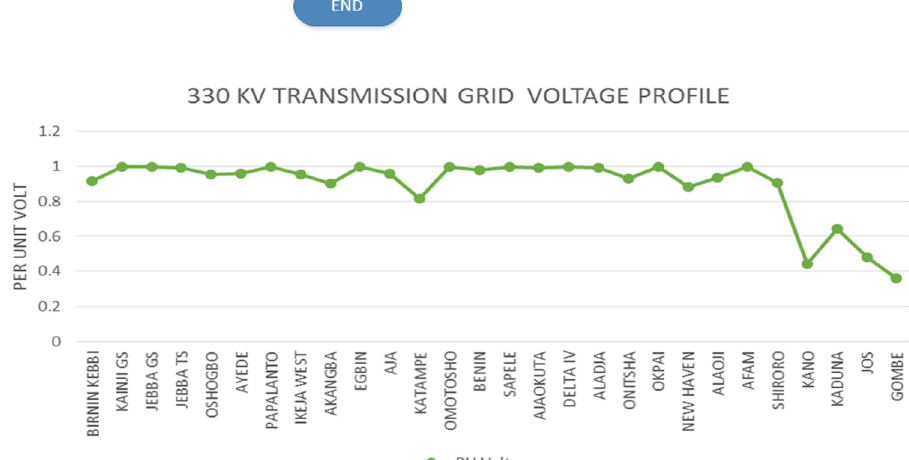
Fig. 7 Voltage profile of the existing 330-kV